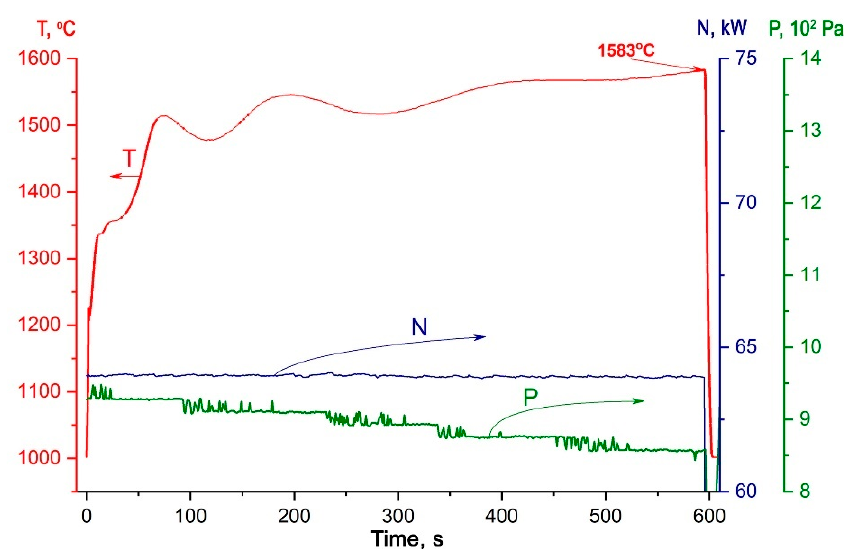
Figure 6. Variation of the color temperature in the center of the sample face (T), plasmatron generator power by anode supply (N) and pressure in the pressure chamber (P) in the experiment on heat exchange of ZHSC ceramics in an underexpanded high-enthalpy nitrogen jet.